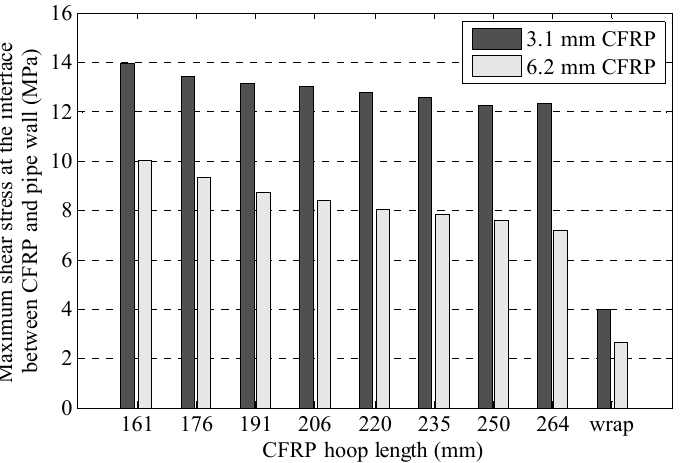
Figure 11. Shear stress between the CFRP and pipe wall.